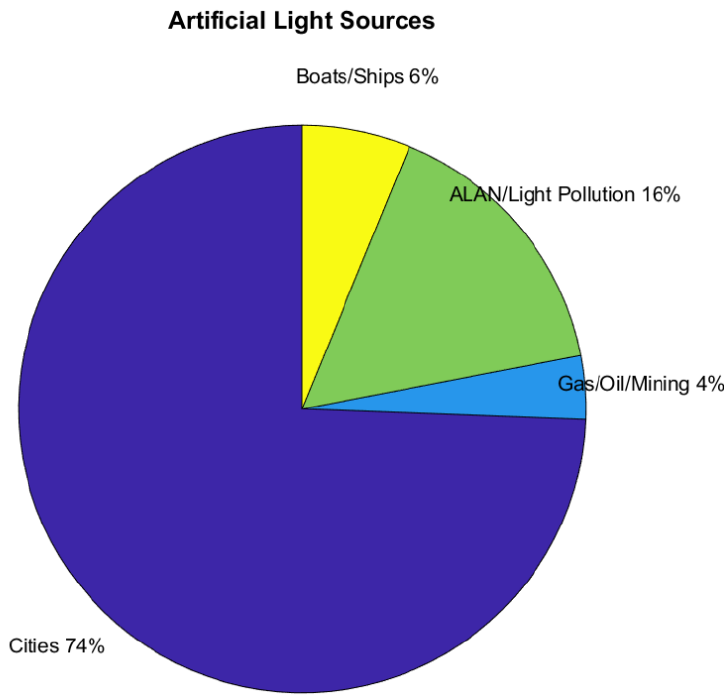
Figure 18. References using artificial light sources.